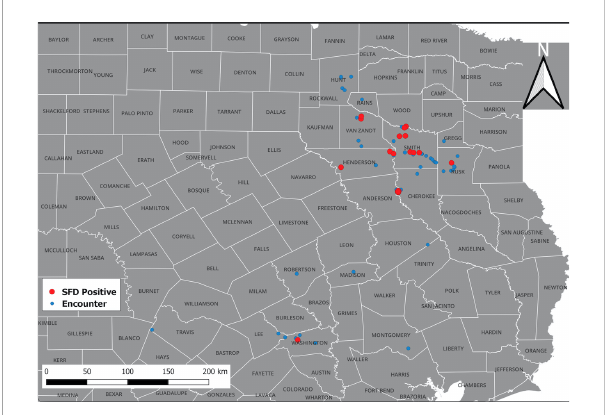
FIGURE 1 Distribution of O. ophidiicola in Texas. Texas State and locations positive for O. ophiodiicola are shown as red dots on the map (Table